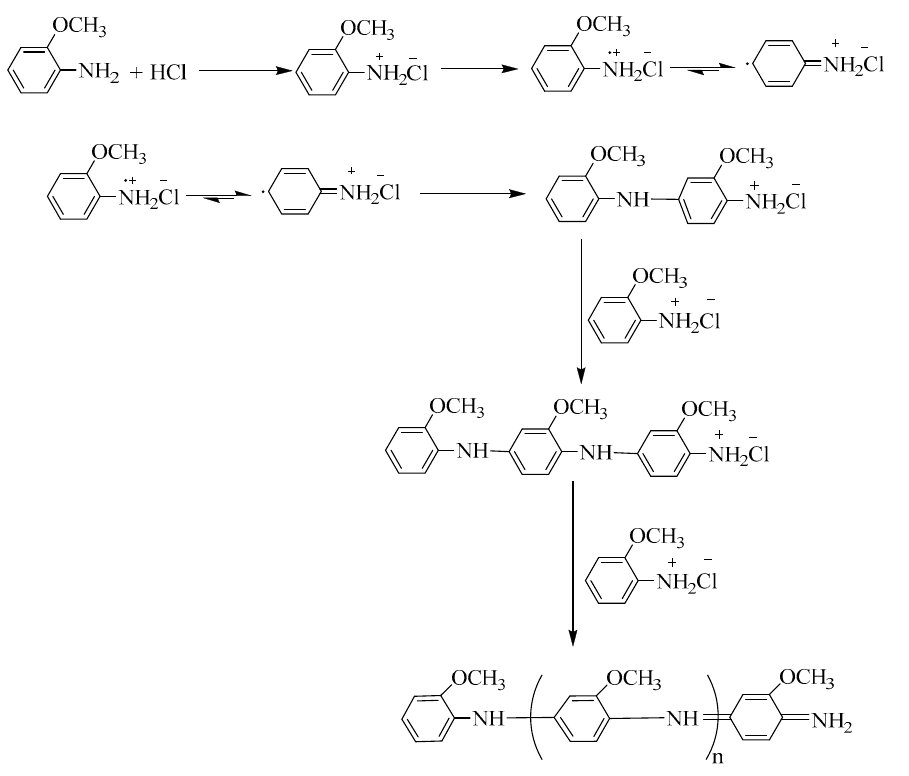
Figure 1. Proposed scheme for polymerization of o -anisidine.